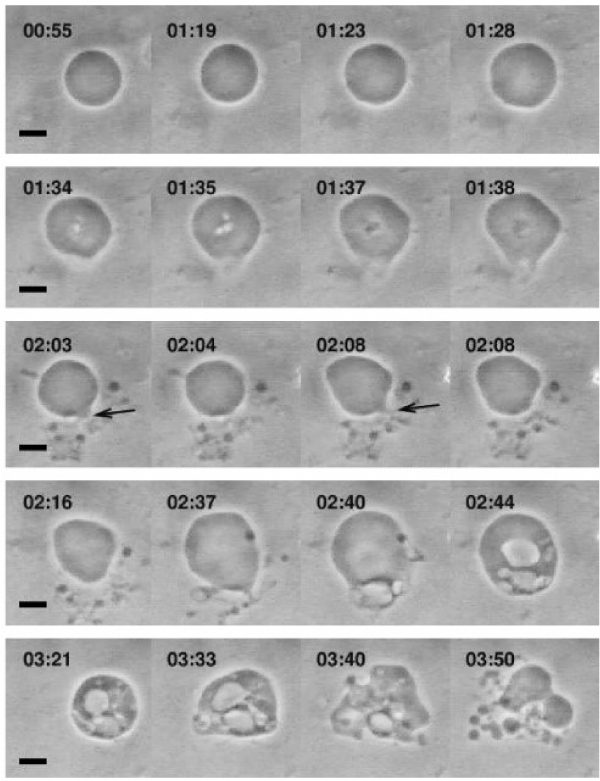
Figure 5. Optical micrographs showing the morphological responses of POPC GUVs that occur upon treatment with 0.8 mM oleic acid solution. The scale bars are 10 µ m. Reproduced with permission from